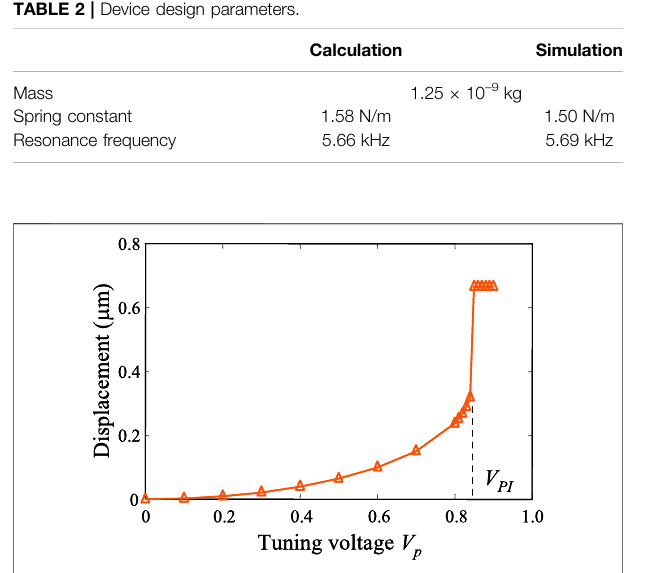
FIGURE 3 | Pull-in voltage simulation.